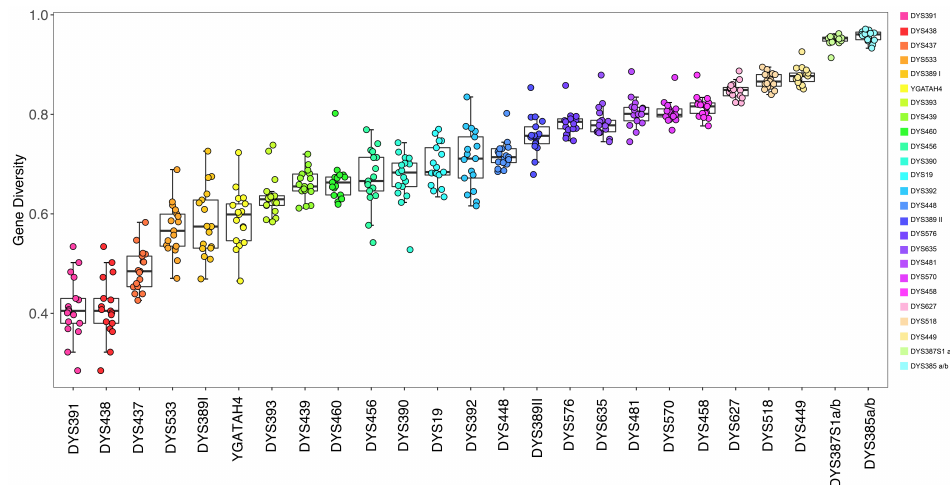
Figure 2. Boxplots comparing GD values in 17 populations based on 27 common Y-STR